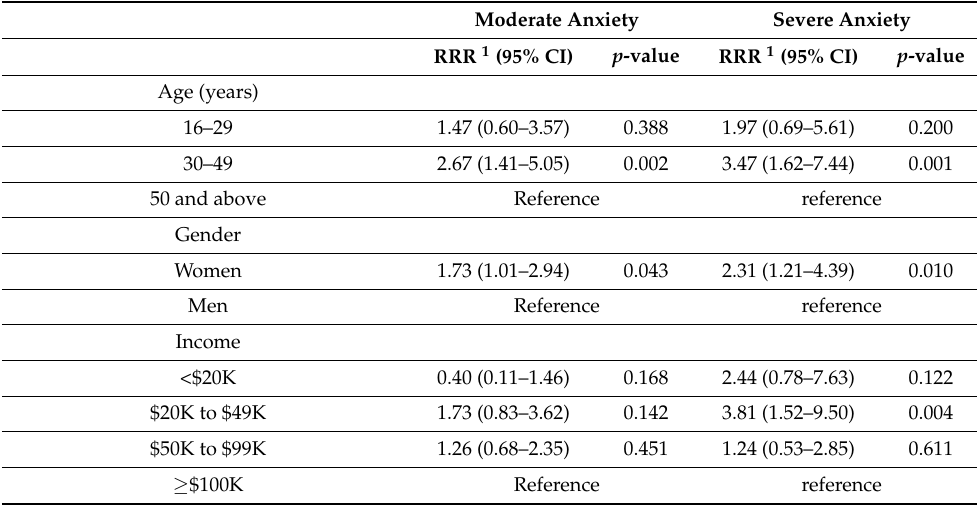
Table 2. Factors associated with self-reported moderate and severe anxiety compared to mild anxi- ety, cycle 5 MHRC survey (1–8 February 2021), Saskatchewan.